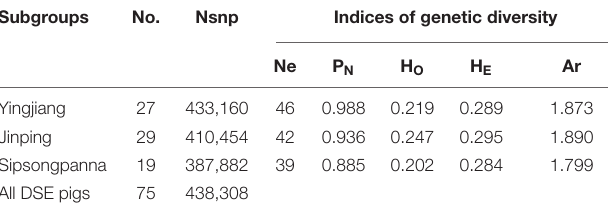
TABLE 2 | Genetic diversity of DSE